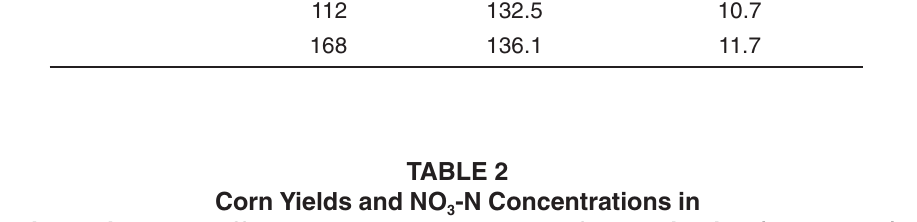
-N Concentrations in 3